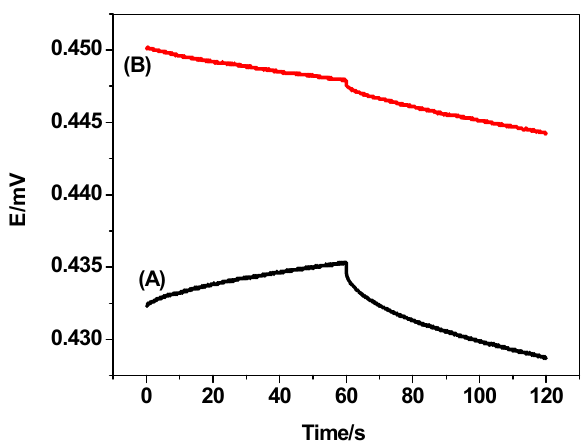
Figure 9. Measurements for dopamine membrane sensor (A) without and (B) with poly (3,4 ethylenedioxythiophene) / poly-(styrenesulfonate) (PEDOT / PSS).